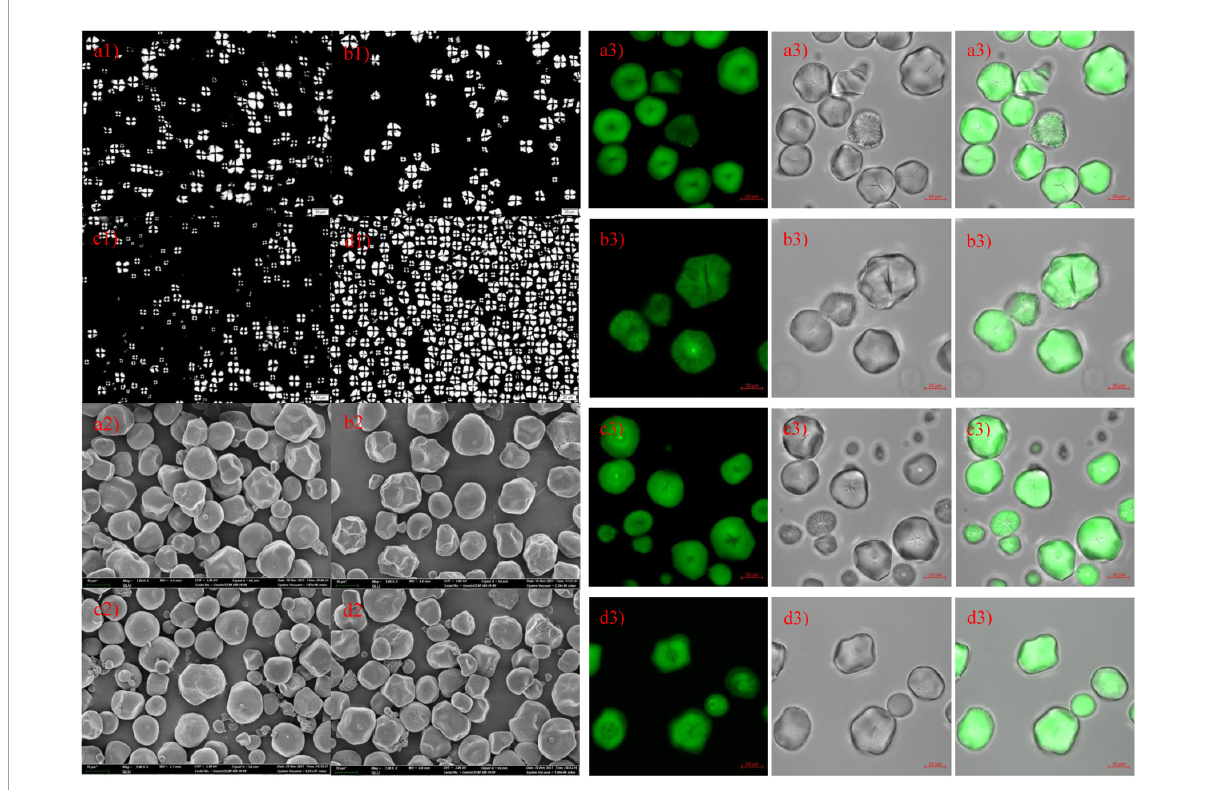
FIGURE2 Polarizing, scanning electron microscopy and confocal laser scanning microscopy of starch from waxy, sweet, and hybrid sorghum. (a1–a3) Hybrid waxy starch; (b1–b3) inbred waxy starch; (c1–c3) hybrid sweet starch; (d1–d3) inbred sweet